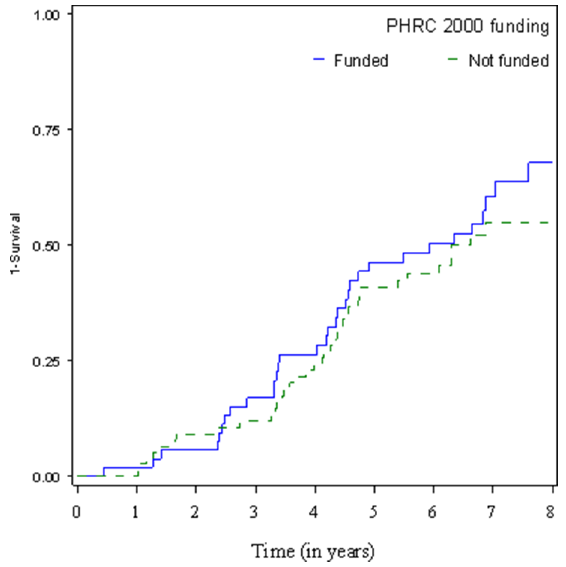
Figure 1. Time to publication.